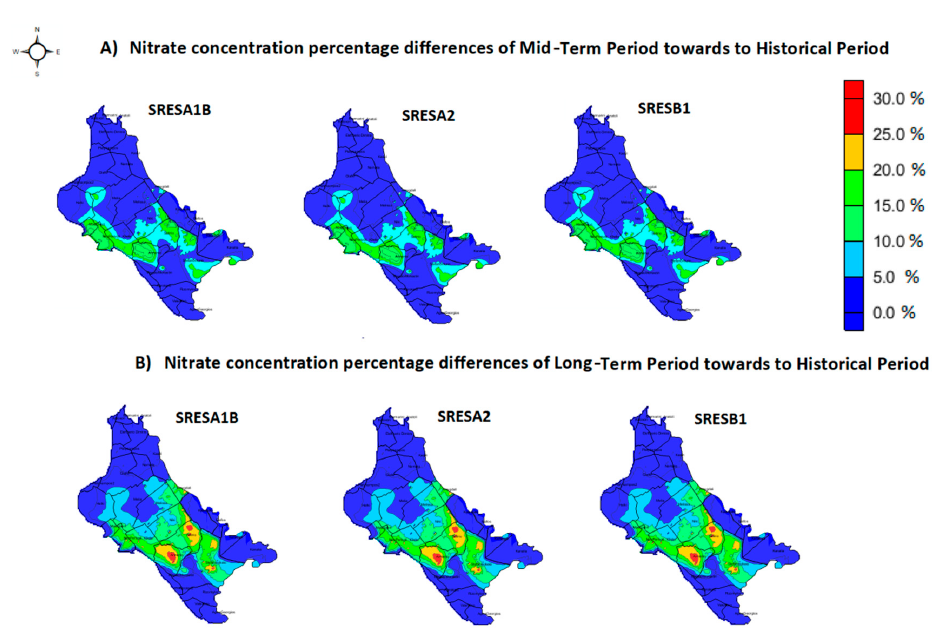
Figure 11. Nitrate concentration percentage differences for all three social-economic scenarios towards to the historical period of no-reservoir status: ( A ) Mid-Term Period and ( B ) Long-Term Period.